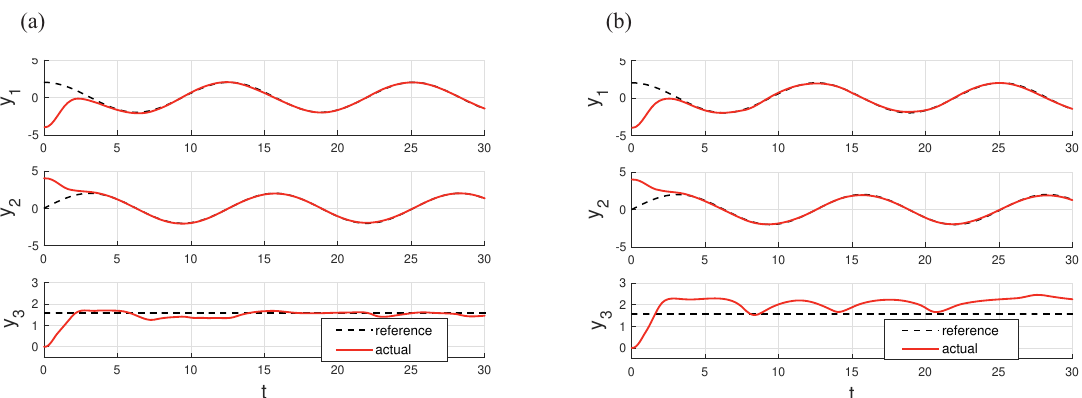
Figure 4. (a) The output trajectories of the U-Cat model in the case when disturbance estimate signal is sent to the controller only at event times; (b) The output trajectories of the U-Cat model in the case when no disturbance estimate is sent to the controller.